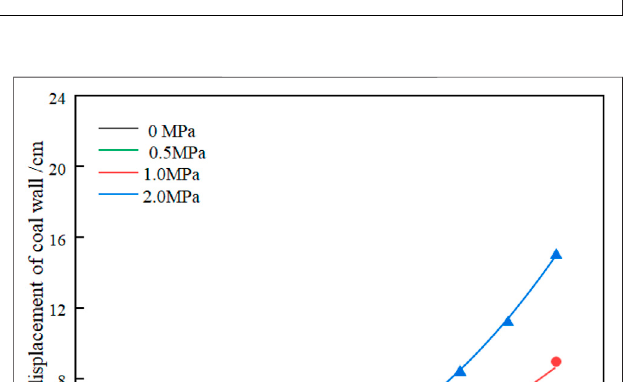
FIGURE 2 | Diagram of the experimental process.